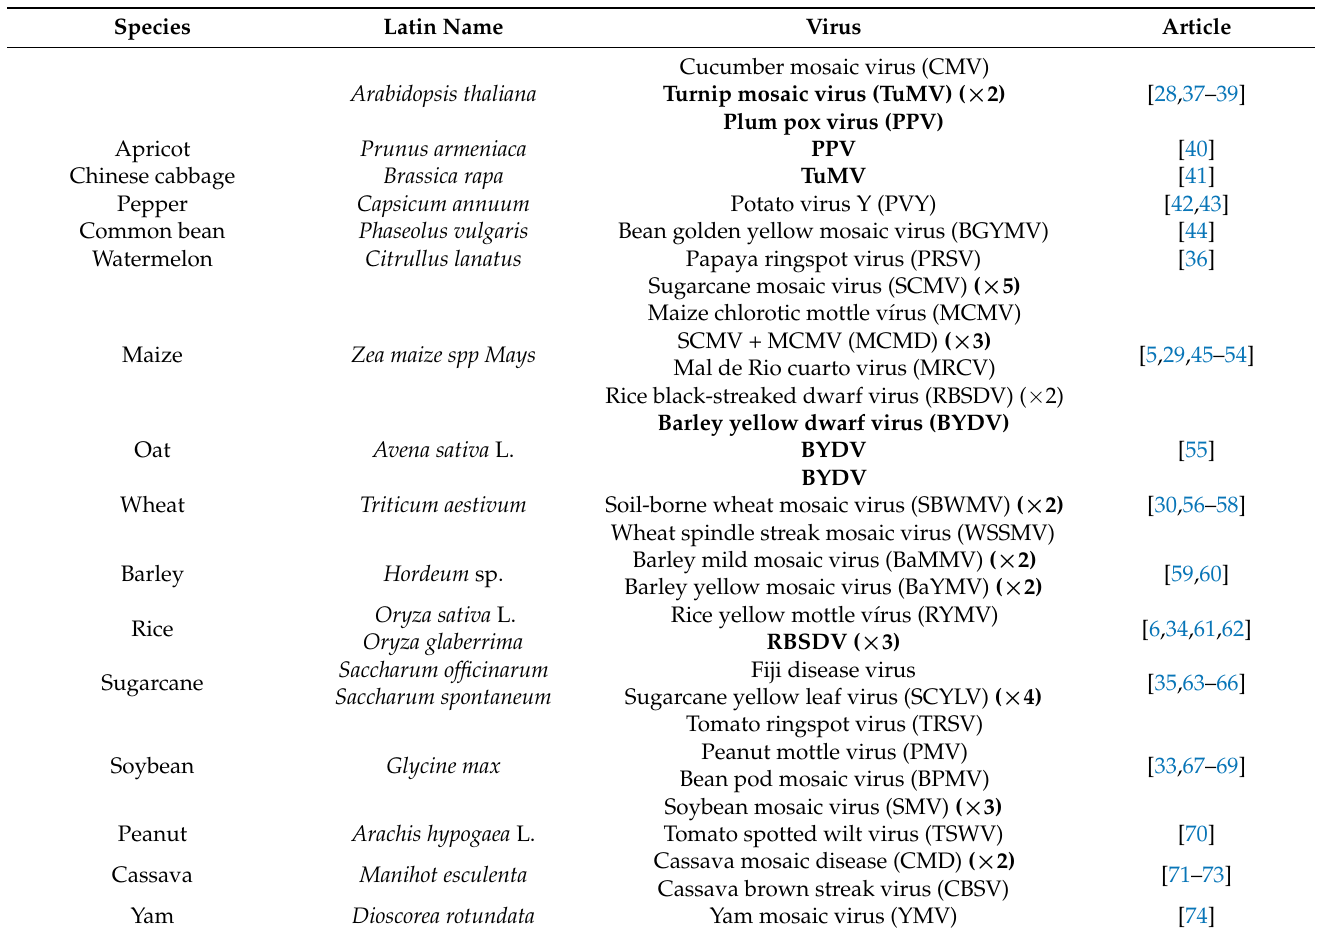
Table 1. Overview of the pathosystems covered by the 48 plant–virus GWAS publications. In bold are the names of viruses studied in several plant species. Bracketed numbers represent publications in which the same plant–virus pair was studied. Further details on the plants, viruses, protocols, and GWAS models and results are outlined in Table